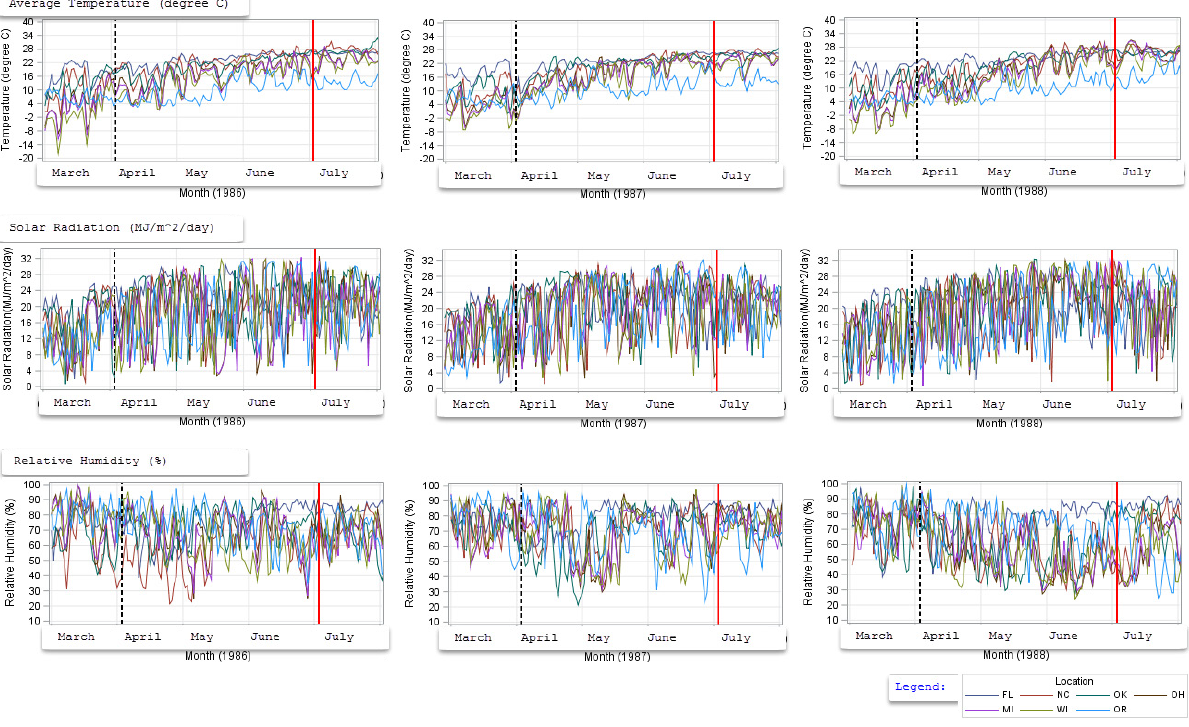
Figure 1: Daily average temperature (ºC), solar radiation (MJ m -2 day -1 ) and relative humidity (%) for location FL, NC, OK, OH, MI, WI and OR for the year 1986 to 1988. Normal growing season of cucumber across tested location is from April to June. This duration is represented between the vertical dashed black and solid red lines